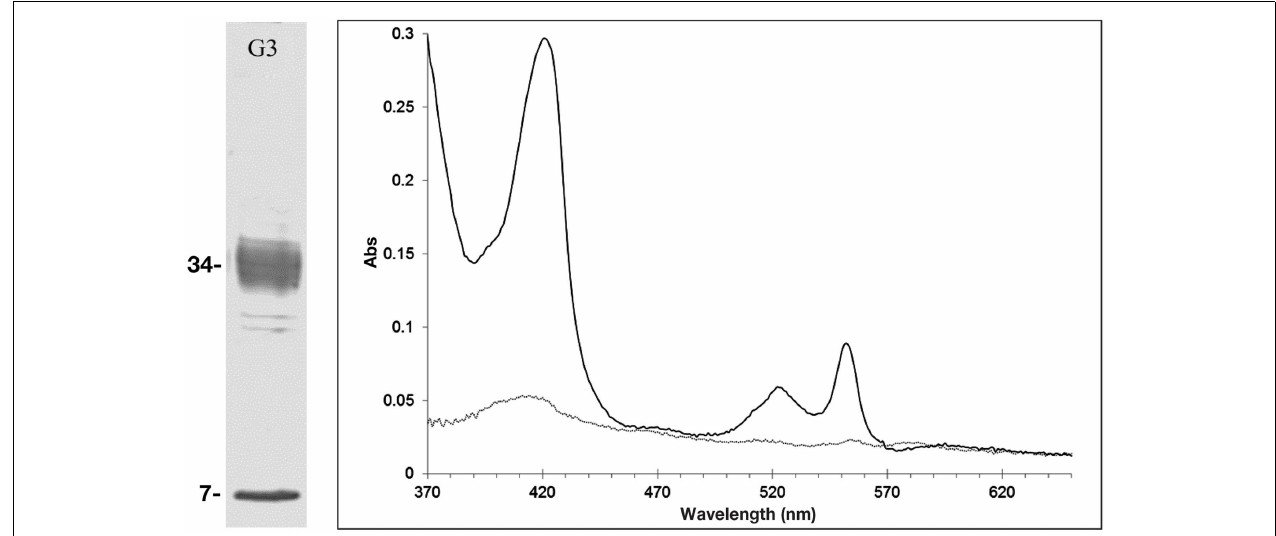
FIGURE 6 |The multiheme cytochrome c annotated as hypothetical protein Gmet_0913 from G. metallireducens . Left panel, SDS-PAGE (G3 refers to fraction G3 of the preparatory electrophoresis). Right panel, the UV/Vis electronic spectra of fraction G3, showing the as-isolated (grey line) and the dithionite reduced spectrum (black